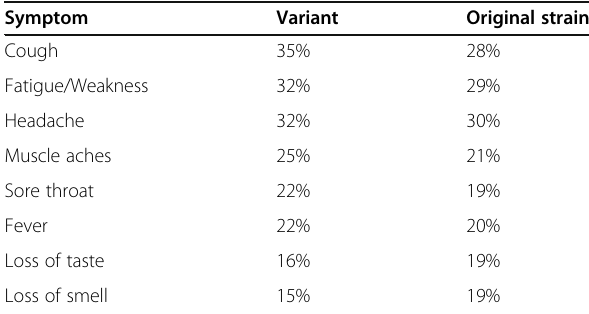
Table 2 Comparison of symptoms between alpha variant and wild strain infected individuals in the UK Symptom Variant Original